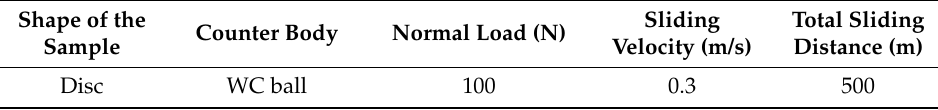
Table 3. Parameters used for the pin-on-disk laboratory wear tests.